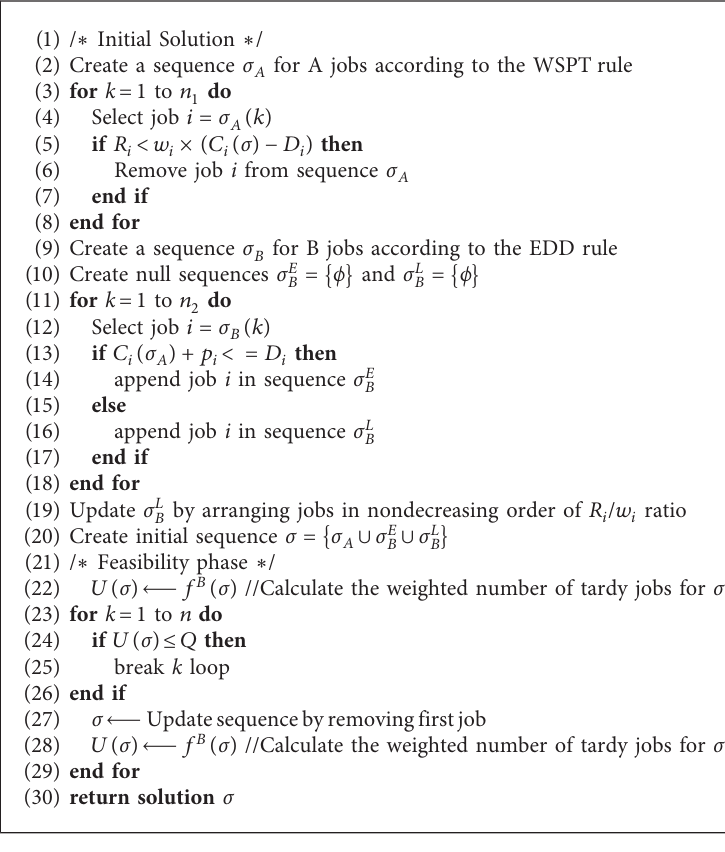
A LGORITHM 1: Heuristic